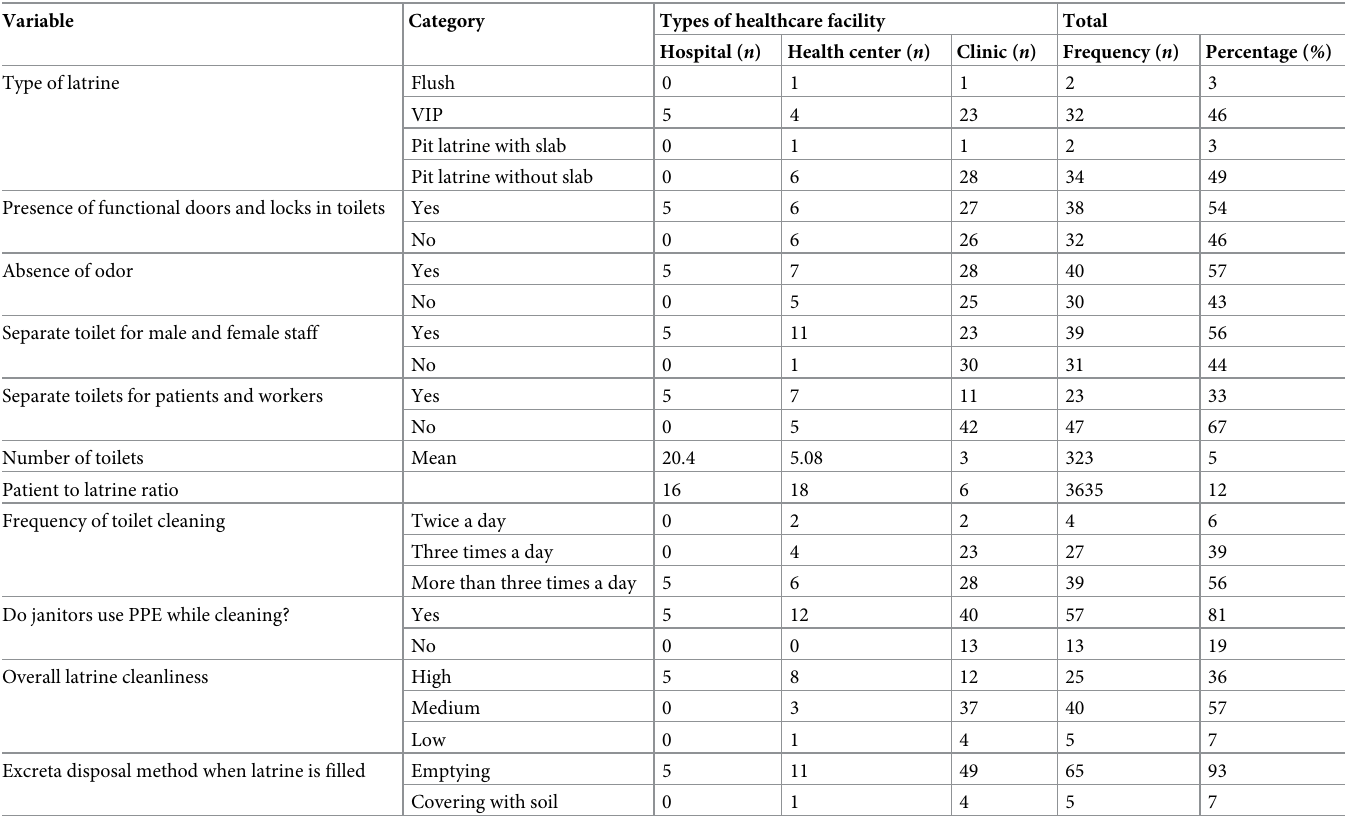
Table 3. Sanitation facilities based on the type of healthcare facility in Northeastern Ethiopia from July to August